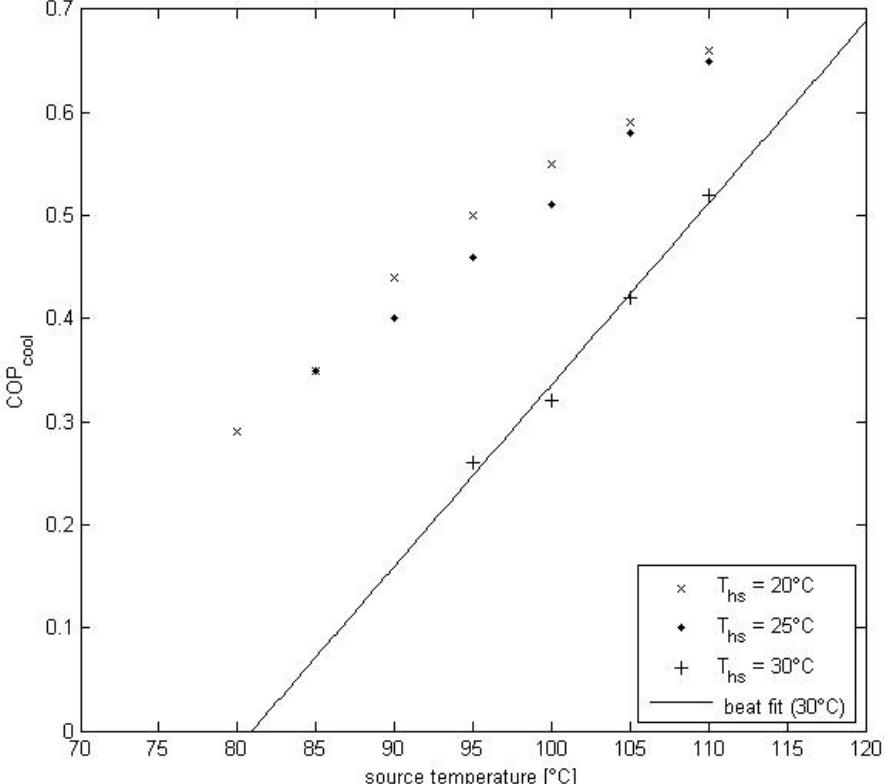
Figure 6. COP against heat source temperature for 26 °C cooling